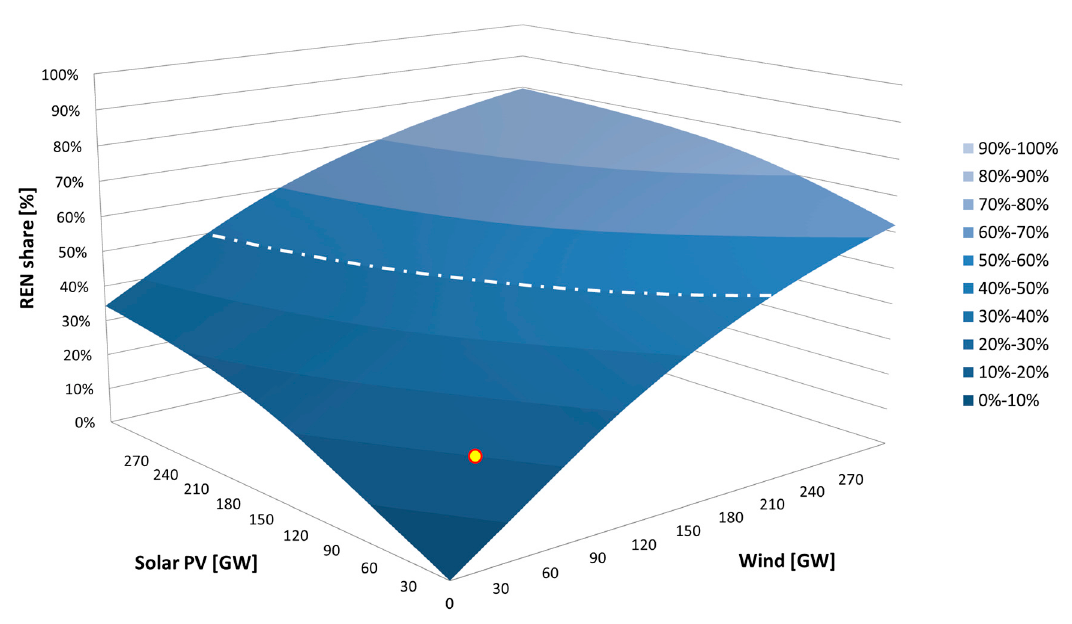
Figure 4. REN share surface plot for Case B, including the 2017 capacities from wind and solar PV (point marking), and the 50% REN share marking for various combinations resulting in a 50% REN share (mixed dotted-dashed line).